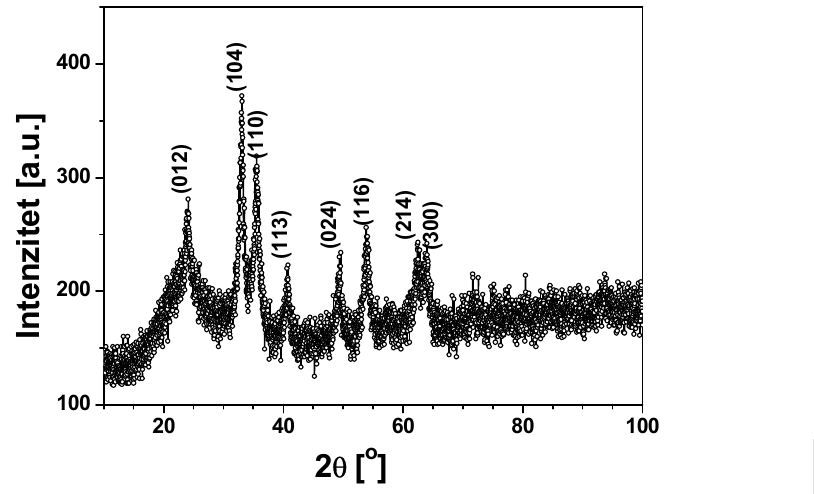
Figure 1 – X-ray powder diffraction pattern of the nanocomposite α -Fe 2 O 3 /SiO